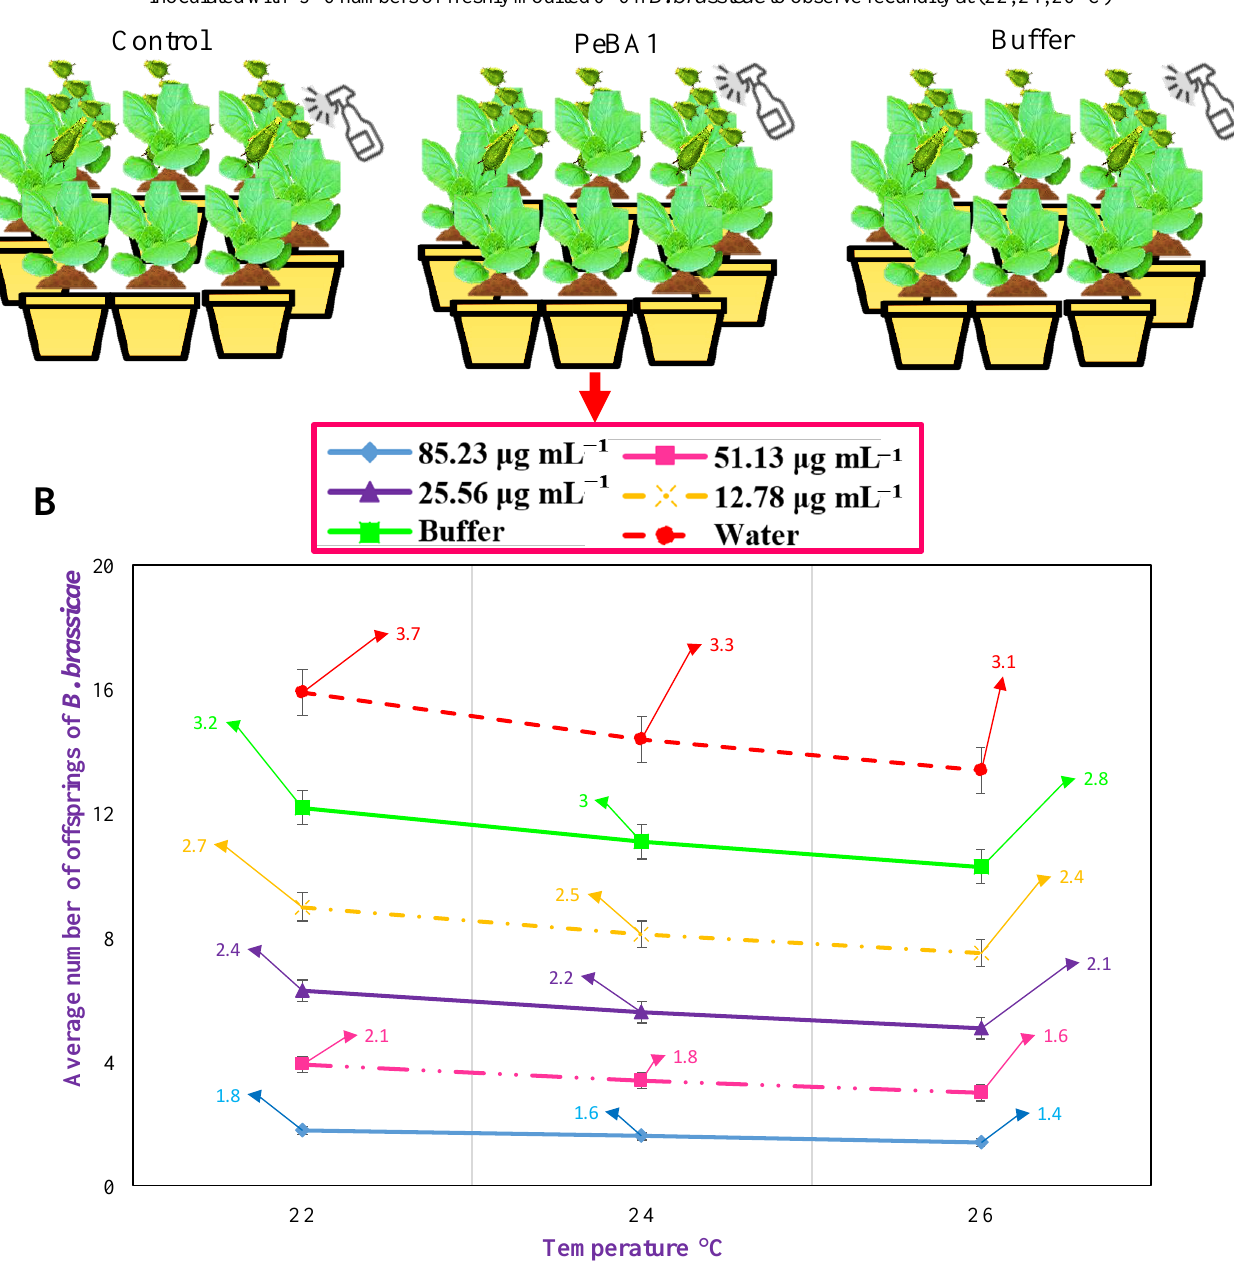
Figure 6. Brevicoryne brassicae fecundity reduced in B. rapa seedlings treated with PeBA1 Seedlings treatment with PeBA1, buffer, and control ( A ). Average fecundity of B. rapa ( n = 10) ( B ). Data shown as mean (±SE) (factorial analysis one-way ANOVA; LSD at α = 0.05).